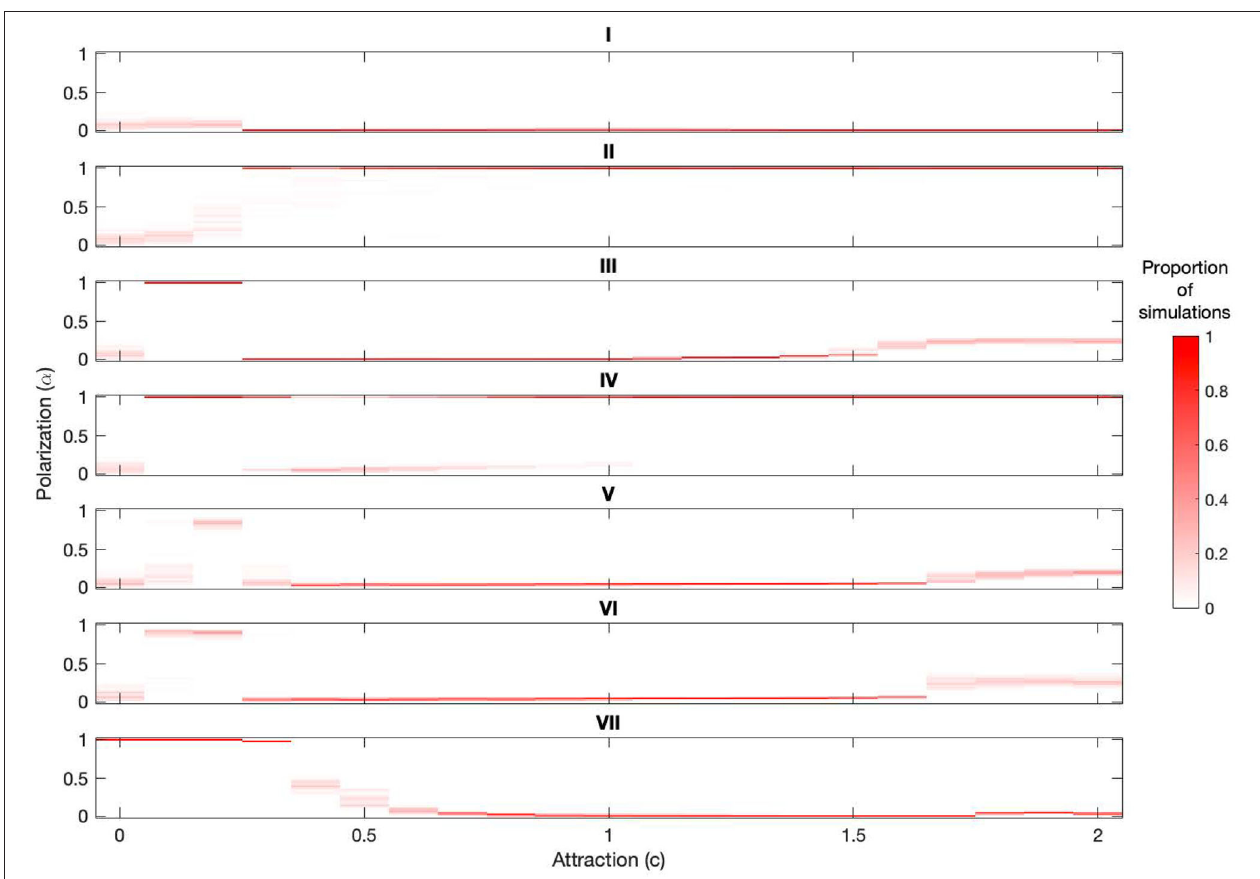
FIGURE 3 | Comparison of models (I)–(VII) over c from 0 to 2. Each plot represents the distribution of polarization values α returned from 100 simulations for each c from 0 to 2 in increments of 0.1. For a particular c value the plot color coding shows the proportion of simulations that returned a particular polarization value, the darker the band the more simulations returned that polarization value. For example, for model (III) with c = 0.1 all simulations returned a polarization value close to 1 (so only polarized groups formed) and with c = 0.5 all simulations returned a polarization value close to 0 (so polarized groups did not form). We note that the synchronous LAM (I) does not produce polarized groups for any value of c , that there are four models that induce polarization for small c only (III,V,VI,VII), one model that induces polarized group formation for larger c only (II), and one model that induces polarized group formation for both small and larger c (IV). We note that the results for (I,III) were originally published in [16] and the result for (IV) in